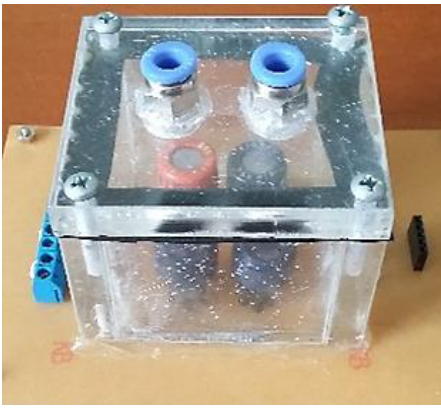
Figure 7. Gas sensor chamber.